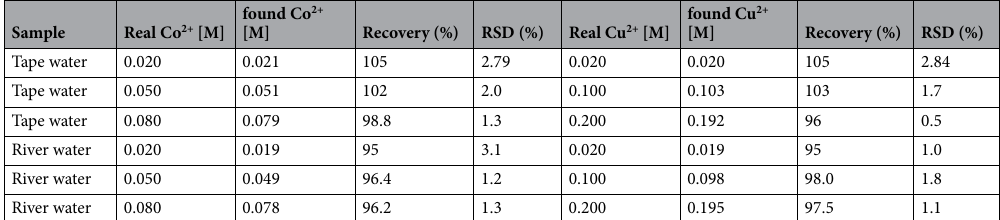
Table 1. The results of Co 2+ and Cu 2+ detections by GQD-EBT in the real samples (N = 3).